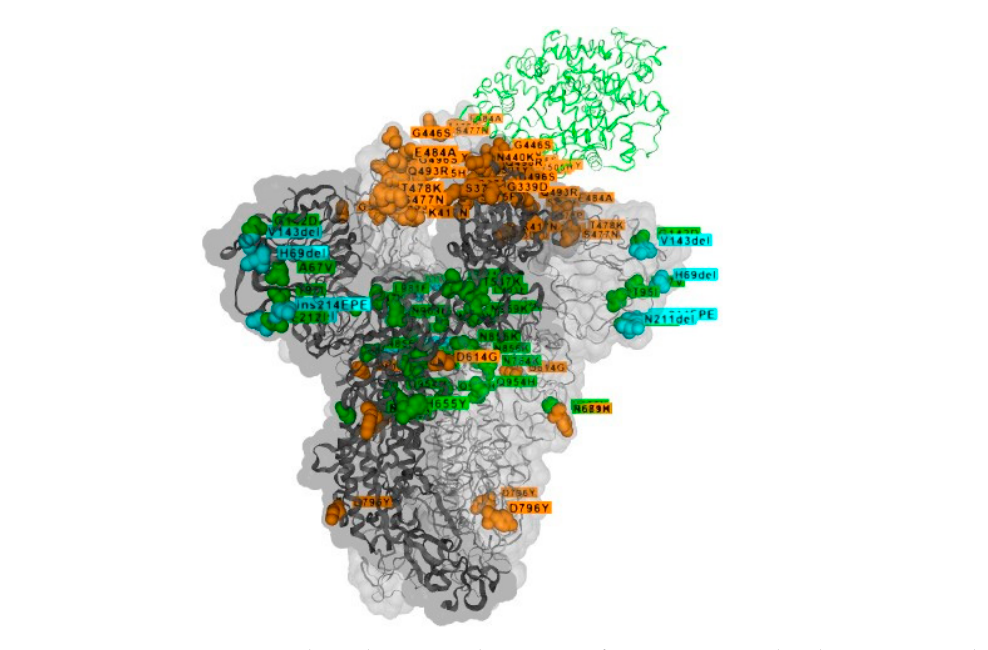
Figure 3. Three-dimensional structure of SARS-CoV-2 spike glycoprotein with positions of amino acid changes in the B.1.1.529+BA lineage ( Ὸ ). Changes with phenotypic effects are indicated as light orange or cyan for insertions/deletions, while variants without documented phenotypic effects are colored in green. Adapted https://www.gisaid.org/hcov19-variants/ (accessed on 8 February 2022).